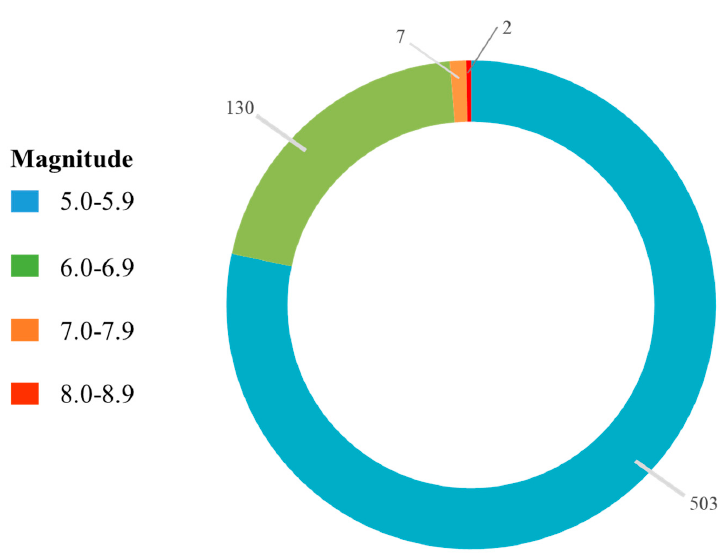
Figure 3. Data on earthquakes in Tibet. Data on earthquakes larger than magnitude 5.0 in Tibet during 1900 and 2017, extracted from the United States Geological Survey (USGS) [26] and the China Earthquake Networks Center (CENC) [27].